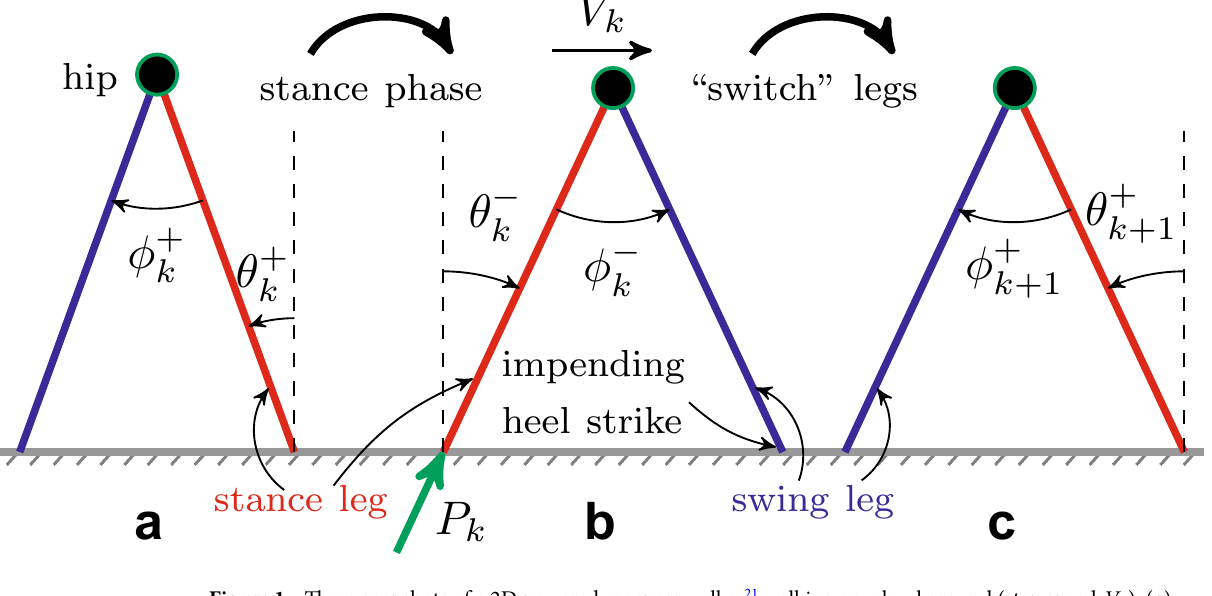
Figure 1. Three snapshots of a 2D powered compass walker 21 walking on a level ground (step speed, V k ): ( a ) just after k th , ( b ) just before ( k + 1 ) st and ( c ) just after ( k + 1 ) st heel strike. The walker has straight, massless, stance ( red ) and swing ( blue ) legs, and a mass at the hip ( circle ). The masses at the feet (not shown) are infinitesimally small compared to the hip mass. The push-off impulse, P , is applied instantaneously just before heel strike. At the beginning of the k th step, the walker’s state in the inertial frame is [ θ + k , ˙ θ + k ] ⊤